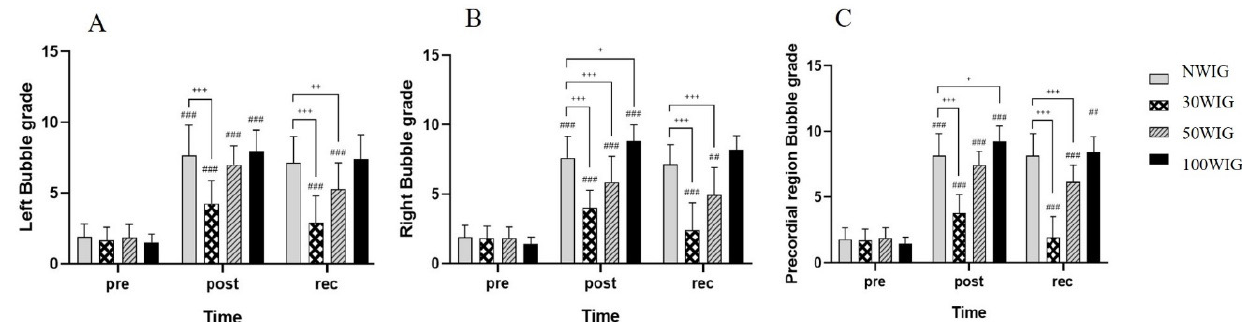
Figure 4. Comparison of bubble grade in the left subclavian vein ( A ), right subclavian vein ( B ), and the precordial region ( C ). Following ANCOVA, Bonferroni post hoc analysis was conducted to the specify protocol effect. NWIG, no-water-intake group; 30WIG, 30%-water-intake group; 50WIG, 50%-water-intake group; 100WIG, 100%-water-intake group. The data are represented as mean ± SD. *, ** and *** represent p ≤ 0.05, p ≤ 0.01 and p ≤ 0.001, respectively, when compared to NWIG at post-dive (post). # , ## , and ### represent p ≤ 0.05, p ≤ 0.01, and p ≤ 0.001, respectively, when compared to NWIG at 30 min into recovery time (rec).